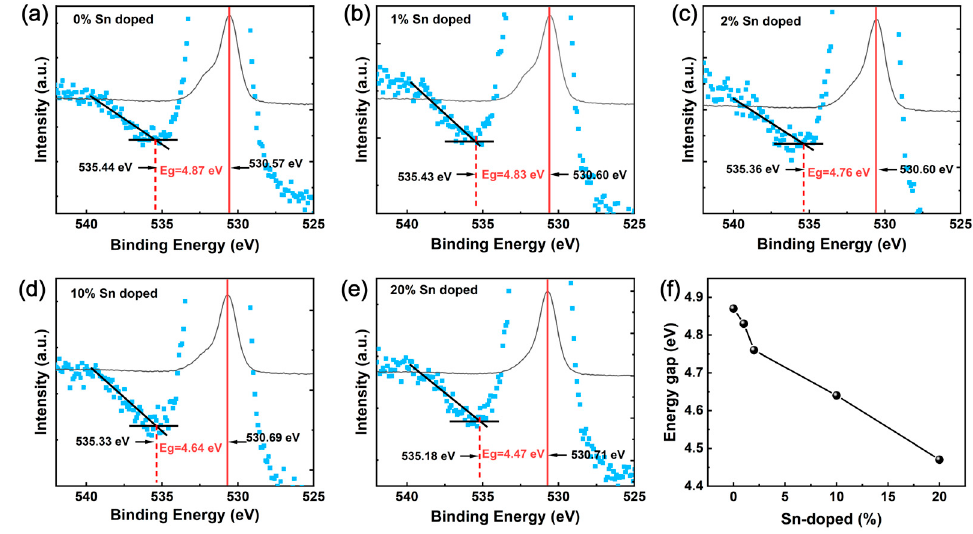
Figure 4. ( a – e ) The estimation of E g values for annealed Ga 2 O 3 thin films doped with different Sn concentrations using the O 1s peak analysis. ( f ) The corresponding E g values versus Sn contents of the films.